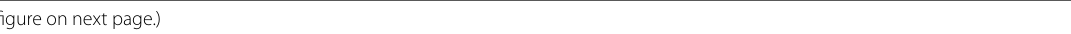
(See figure on next page.) Fig. 5 Inhibition of lipoxin A4receptor (ALXR) abolishes the beneficial effects of MaR1 in I/R-induced liverdamage. a Westernblot of whole-cell lysates from primary mouse HC and NPC assessing proteinexpression of ALXR at the baseline. WT mice were treated with/without ALXRinhibitor (Boc2; 50 mg/kg, i.p.) 1 h prior to liver I/R with PBS or MaR1(20 ng/mouse, i.v.) b , c Serum ALT and AST levels in indicatedgroups after 6 h reperfusion (n 3 in sham groups; n 6 in I/Rgroups). d Representative liverH&E staining (original magnification 20) from indicated groups. e Quantitation = = × of liver necrotic areas,quantified in bar graph; n 5 for each I/R group; f Serum IL-6 levels in indicated groups. g Western blot analysis of = cleaved-caspase 3 in liver tissue frommice subjected to I/R insult in the indicated group. Dataare presented as mean SEM. * P < 0.05, ** P < ±